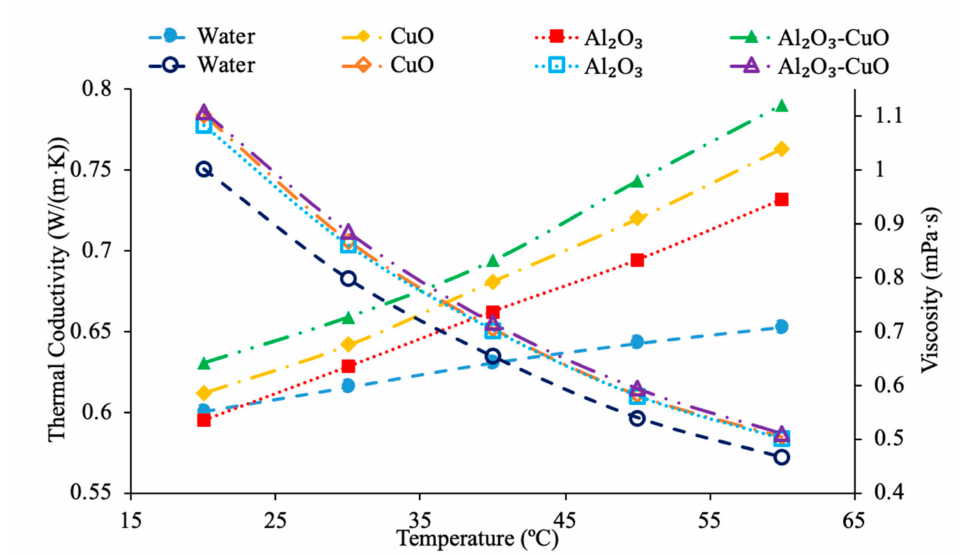
Figure 34. Thermal conductivity (increasing with temperature) and viscosity (decreasing with temperature) of water-based Al 2 O 3 , CuO, and Al 2 O 3 –CuO nanofluid at a volume concentration of 0.2%